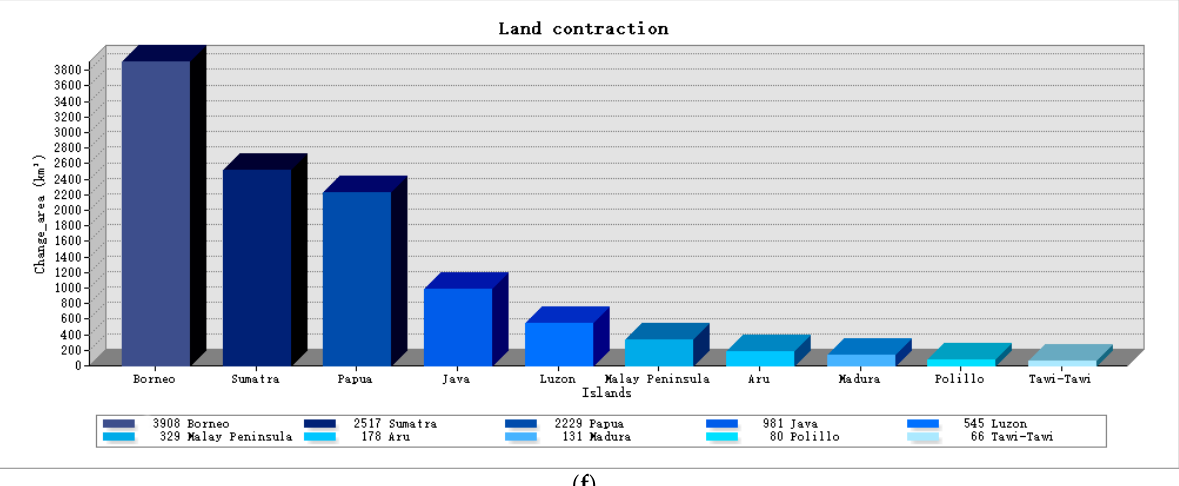
Figure 10. Regions with obvious expansion and contraction. ( a , b ) schematic diagrams of land expansion and contraction changes in the study area (classified by the size of the change); ( c , e ) expansion and contraction of the geographic location of the top 10 regions (classified by natural islands); ( d , f ) expansion and contraction of the specific names and areas of the top 10 regions.